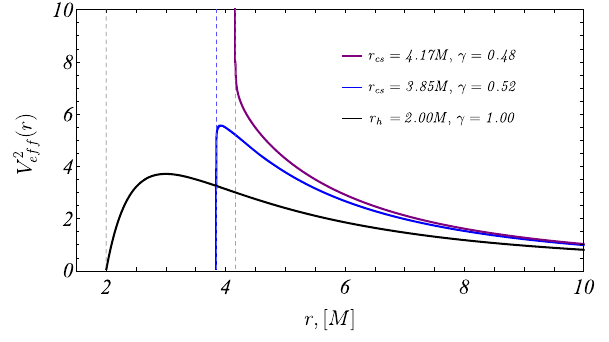
Fig. 1 Effective potential for the null geodesics for weakly naked sin- gularities (blue solid line), strongly naked singularities (purple solid line), and the Schwarzschild black hole (black solid line). The loca- tion of the curvature singularity r cs for the naked singularities, and the event horizon r h for the Schwarzschild black hole is represented in each case by a dashed line in the corresponding color. For the weakly and strongly naked singularities we choose values of the solution parameter γ = 0 . 52 and γ = 0 . 48 respectively. For all the curves the specific angular momentum is set to L =